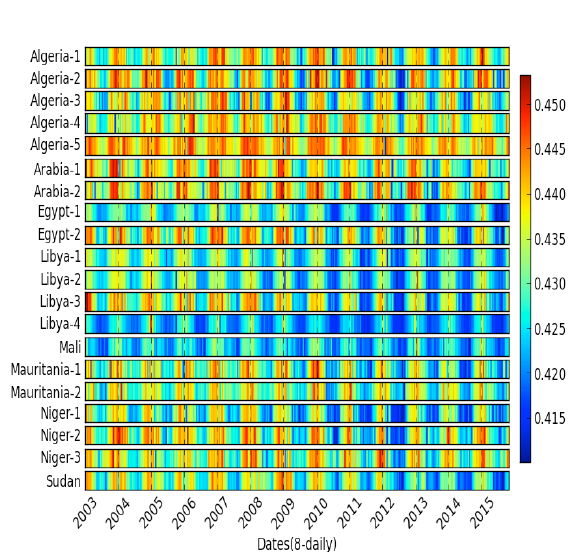
Figure 1. Shortwave White-sky-albedo (WSA) by site, 8 daily for 13 years (2003-2015).